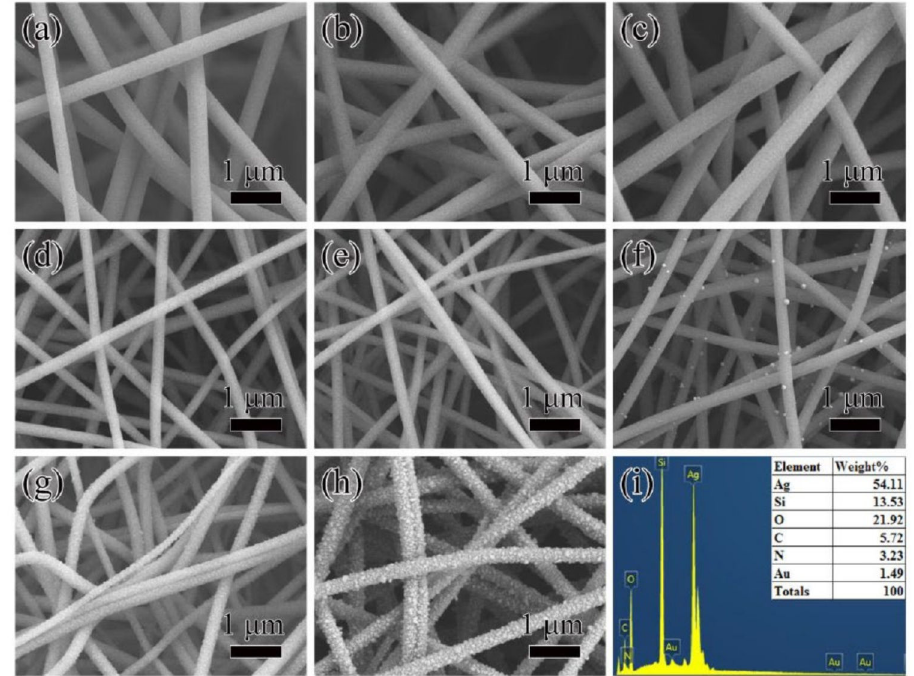
Figure 2. SEM images for nanofibers of SiO 2 @Au-10 precursor ( a ), SiO 2 @Au-20 precursor ( b ), SiO 2 @Au-30 precursor ( c ), SiO 2 @Au-10 ( d ), SiO 2 @Au-20 ( e ), SiO 2 @Au-30 ( f ), T-A@SiO 2 @Au-20 ( g ),